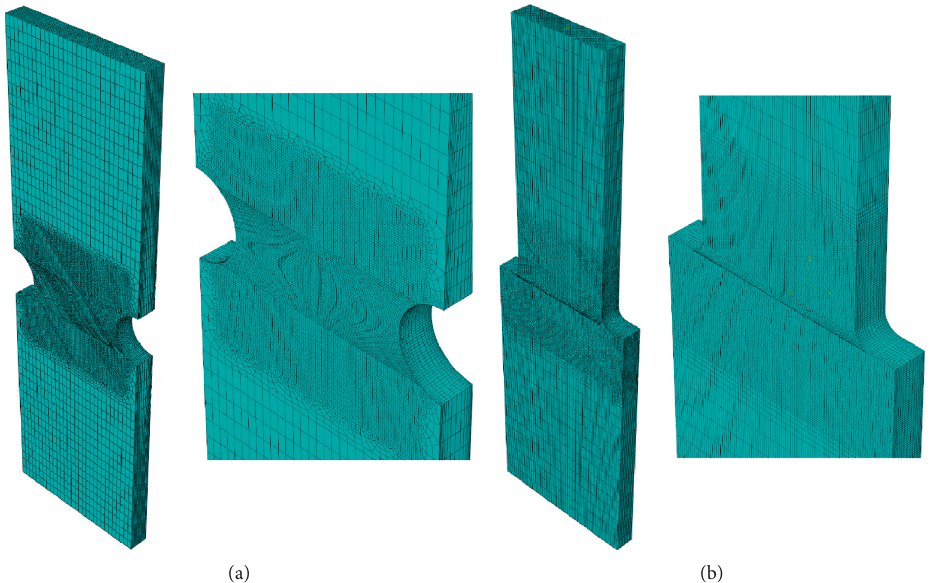
Figure 5: Finite element model of (a) notched and (b) fillet samples.